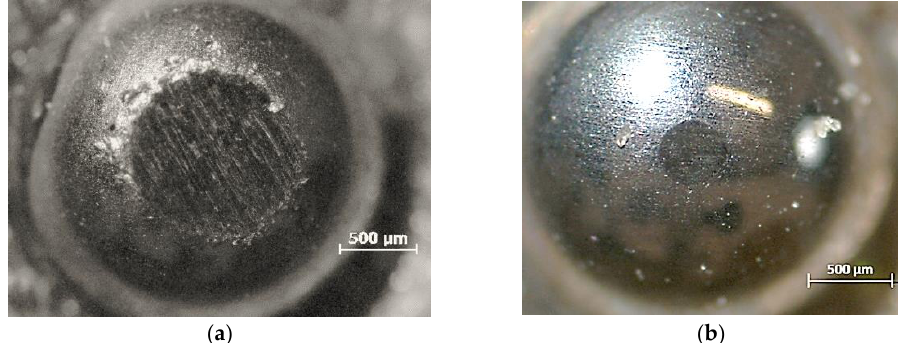
Figure 13. Spheres wear after the metal marking test ( a ) AISI 304 and ( b ) AISI 420. Scanning electron microcopy shows that the mechanical phenomenon occurring with knives is perfectly reproduced with steel balls, as shown in Figure 14.